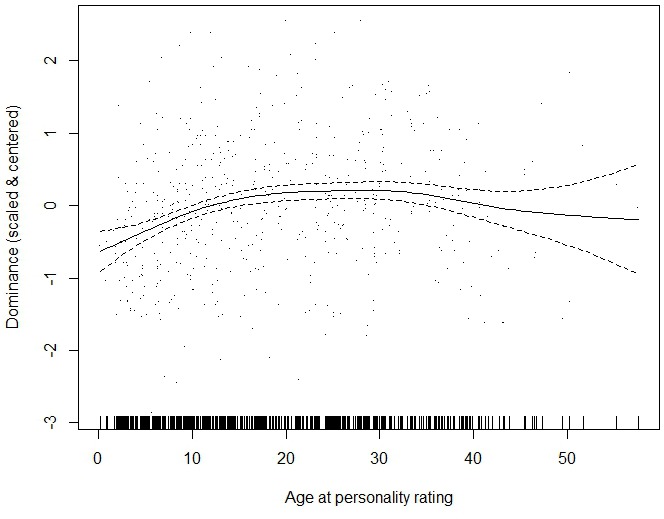
Generalized additive model of dominance and age at personality rating.The carpet and scatter plot present the distribution of observations over which the best fit smoothed regression line is plotted with the 95% confidence region.